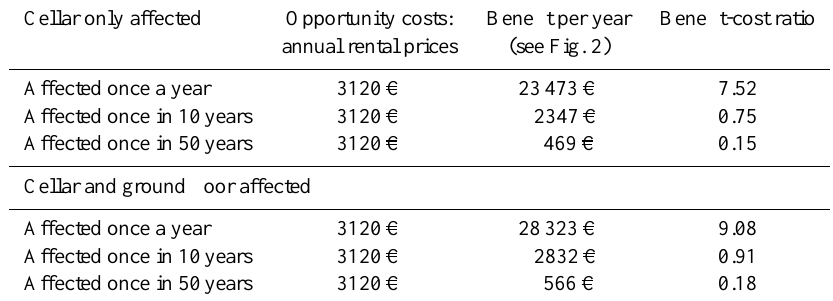
Table 3. Benefit-cost ratios for the construction of residential buildings without a cellar.